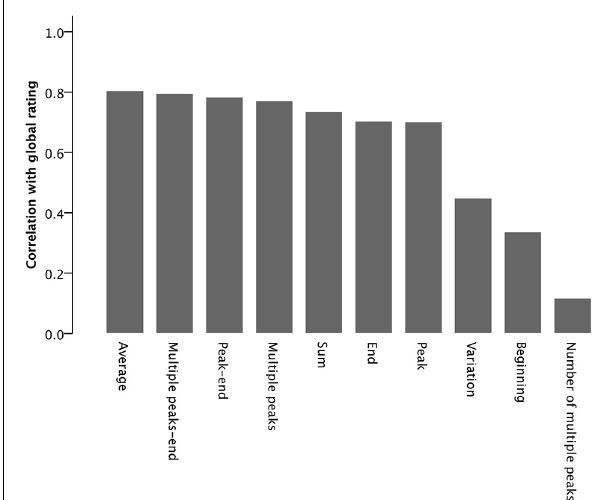
FIGURE 3 | Pearson correlations between the overall evaluation and all the parameters of moment-to-moment experience ( N =